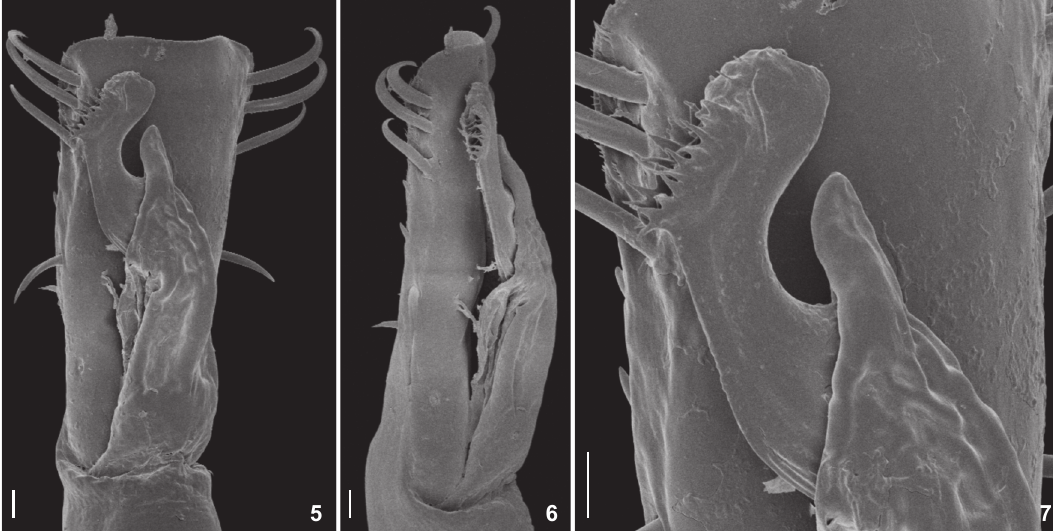
Figures 5-7. Penis of Paecilaema batman sp. nov. : (5) dorsal view; (6) lateral view; (7) detail of glans. Scale bar = 0.02